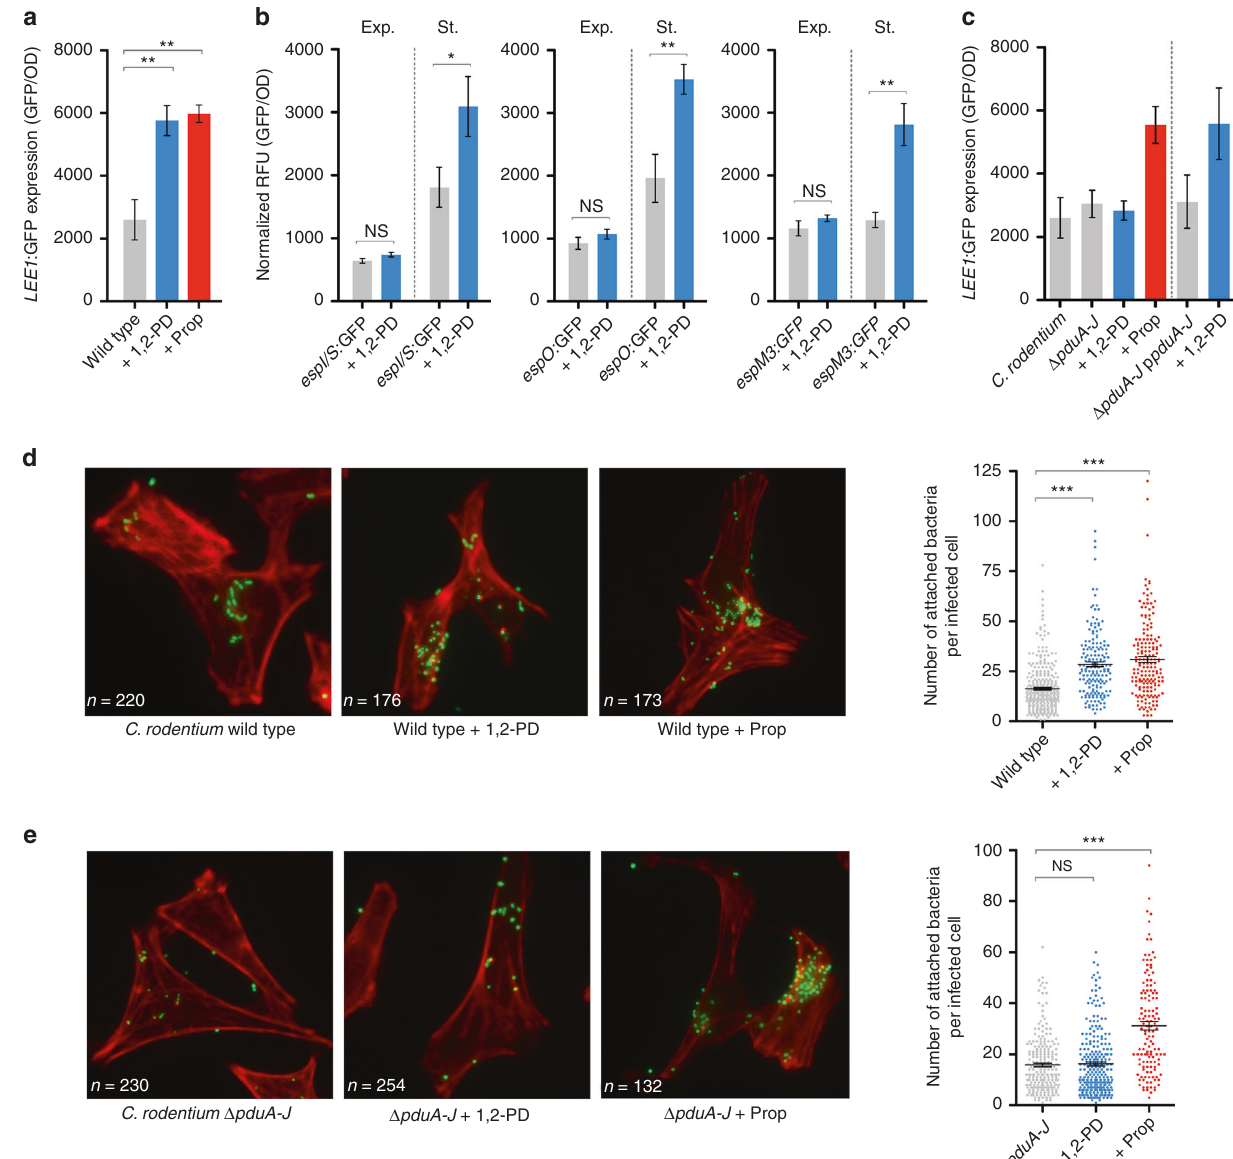
Fig. 5 1,2-propanediol metabolism fi ne-tunes C. rodentium virulence. a LEE1 :GFP reporter activity in DMEM supplemented with 1 mM 1,2-PD or 10 mM Prop. Bacteria were sampled during exponential phase. LEE1 expression was measured as GFP/OD 600 . Data represents the mean of three biological replicates ± SEM. ** denotes P ≤ 0.01 (Student ’ s t -test). b Reporter assays using p espI/S :GFP, p espO :GFP or p espM3 :GFP in DMEM with and without 1,2-PD supplementation. Data were collected at either exponential (Exp.) or stationary (St.) phase. Relative fl uorescence units (RFU) were measured as GFP/ OD 600 and the data represent the mean of three biological replicates ± SEM. *, ** and NS denote P ≤ 0.05, P ≤ 0.01 and not signi fi cant, respectively (Student ’ s t -test). c LEE1 :GFP reporter activity of Δ pduA-J in response to 1,2-PD or Prop. LEE1 :GFP assays performed with Δ pduA-J carrying pBAD: pduA-J for complementation are separated by the grey dotted line. Data represent the mean of three biological replicates ± SEM. d Wide- fi eld fl uorescence microscopy images of attaching and effacing lesion formation on HeLa cells by C. rodentium , with and without 1,2-PD or Prop supplementation. Host cell actin is stained in red (phalloidin-568), whereas bacteria are green (transformed with p rpsM :GFP). Condensed actin can be seen around the area of colonization. The number of cells analysed from three independent experiments is indicated on each image. Enumeration of A/E lesions per infected host cell (±SEM) is indicated on the right. *** denotes P ≤ 0.001 compared to the wild type (Student ’ s t -test). e Analysis of A/E lesion formation on HeLa cells by the C . rodentium Δ pduA-J mutant, with and without 1,2-PD or Prop supplementation. Data were analysed as per panel